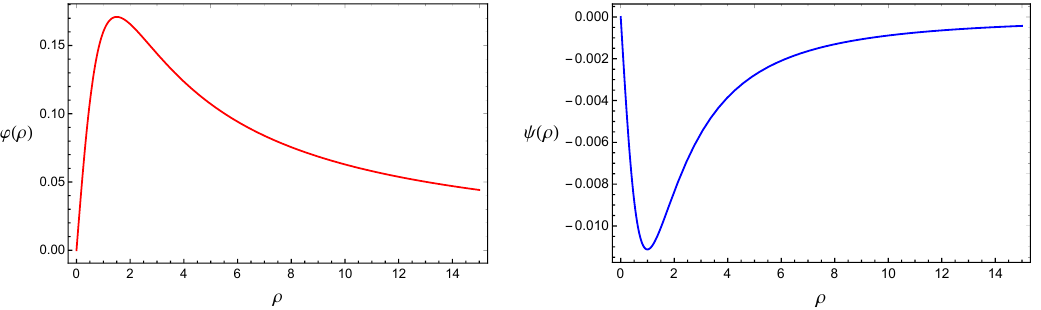
Figure 1 . Sample solutions for the scalar (left panel) and gauge (cid:12)eld (right panel) pro(cid:12)les in